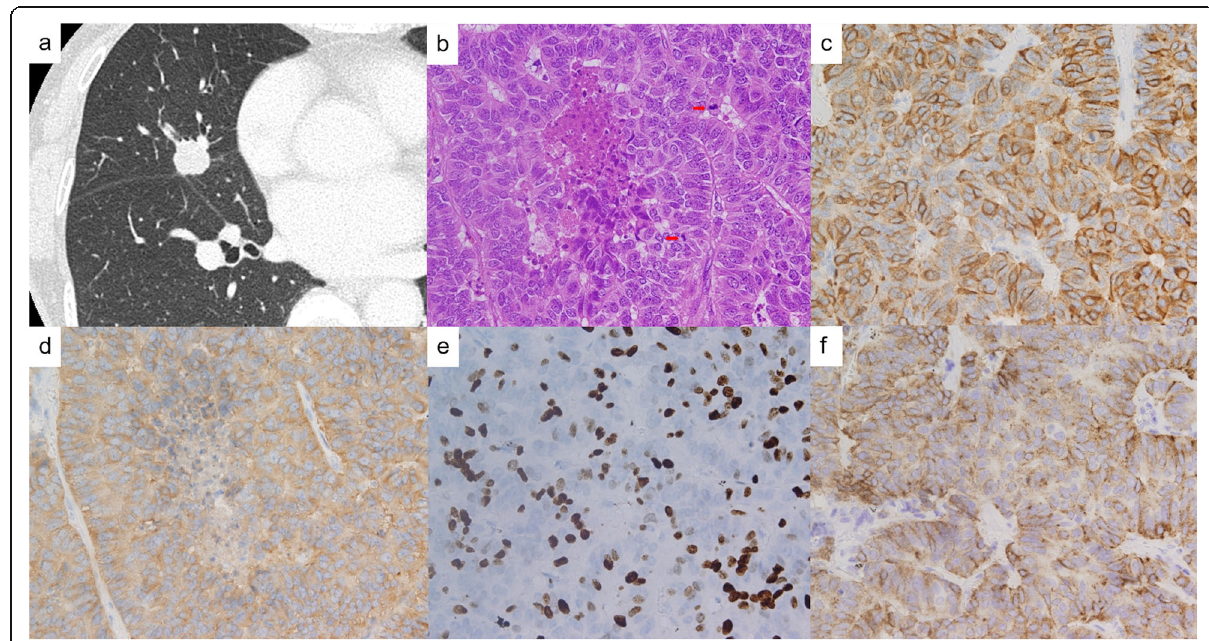
Fig. 1 Radiological image and histopathological findings in case 1. a CT showed a 1.6-cm mass in the peripheral zone of right S4. b Solid growth pattern was seen with central small necrosis. Two mitotic figures (red arrows) were observed (hematoxylin and eosin stain, × 40). c Tumor cells found positive for chromogranin A. d Tumor cells found positive for synaptophysin. e 40% of tumor cells found positive for Ki67. f SSTR-2 staining showed presence of a membranous pattern of staining in less than 50% of tumor cells (score 2). +